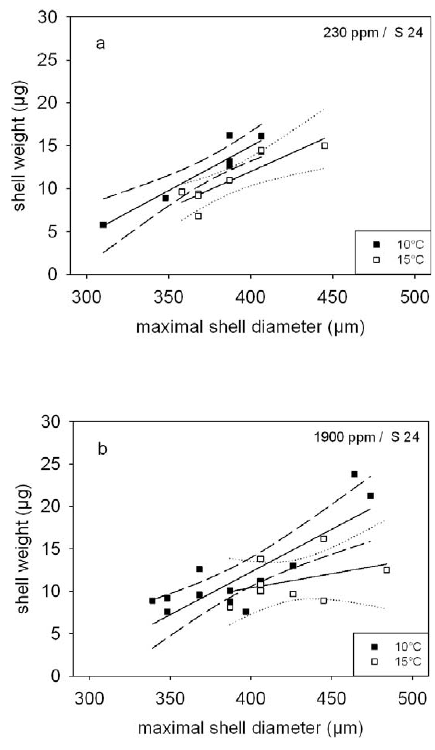
Fig. 4. Weight (µg) versus size (µm) of foraminifera grown at salin- ity 24, under 230ppmv (a) and 1900ppmv (b) . Closed squares rep- resent foraminifera grown at 10 ◦ C and open squares foraminifera grown at 15 ◦ C. Full lines represent linear regression for each ex- perimental condition. Dashed lines indicate the corresponding 95% confidence interval for the